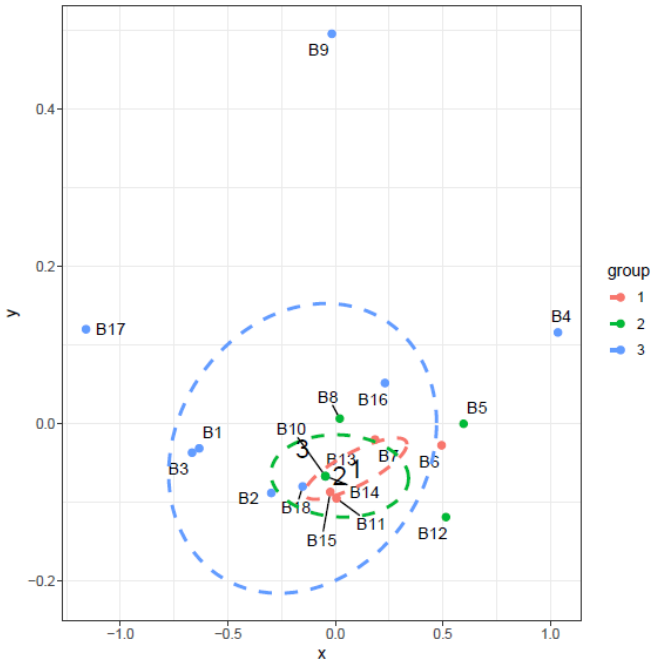
Figure 19. NMDS visualizing the level of similarity for the factor—floor of the apartments.